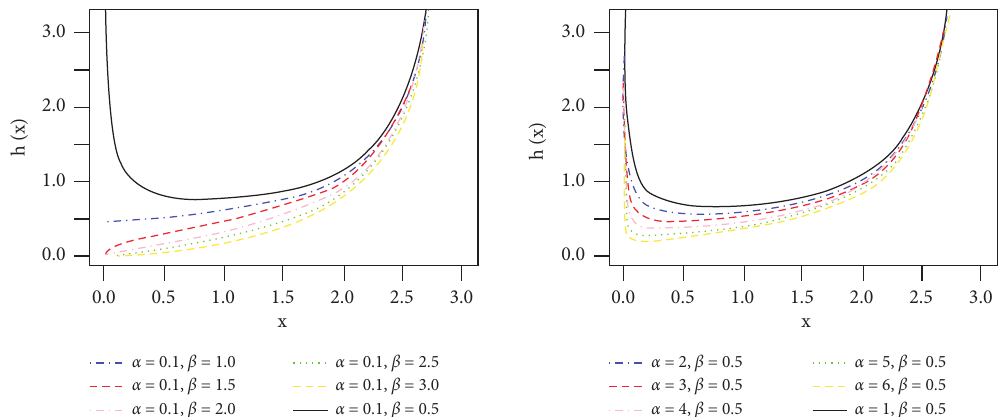
Figure 2: Some curves of the HRF for the EPF